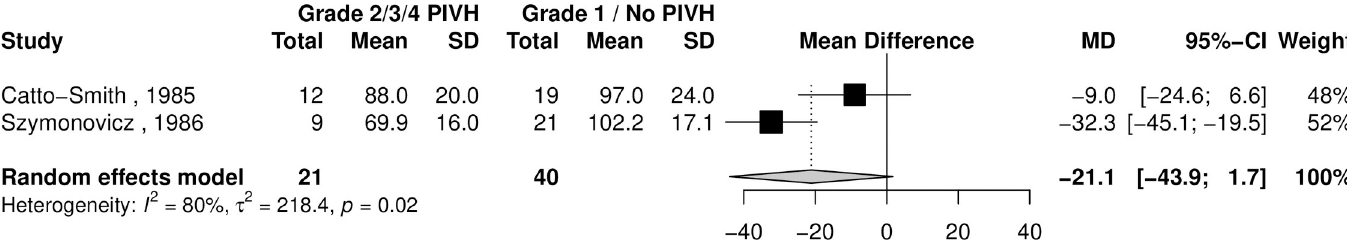
Fig 3. Absolute mean difference of psychomotor development index between children with no or grade 1 peri-intraventricular haemorrhage (PIVH) and children with higher degrees of PIVH.